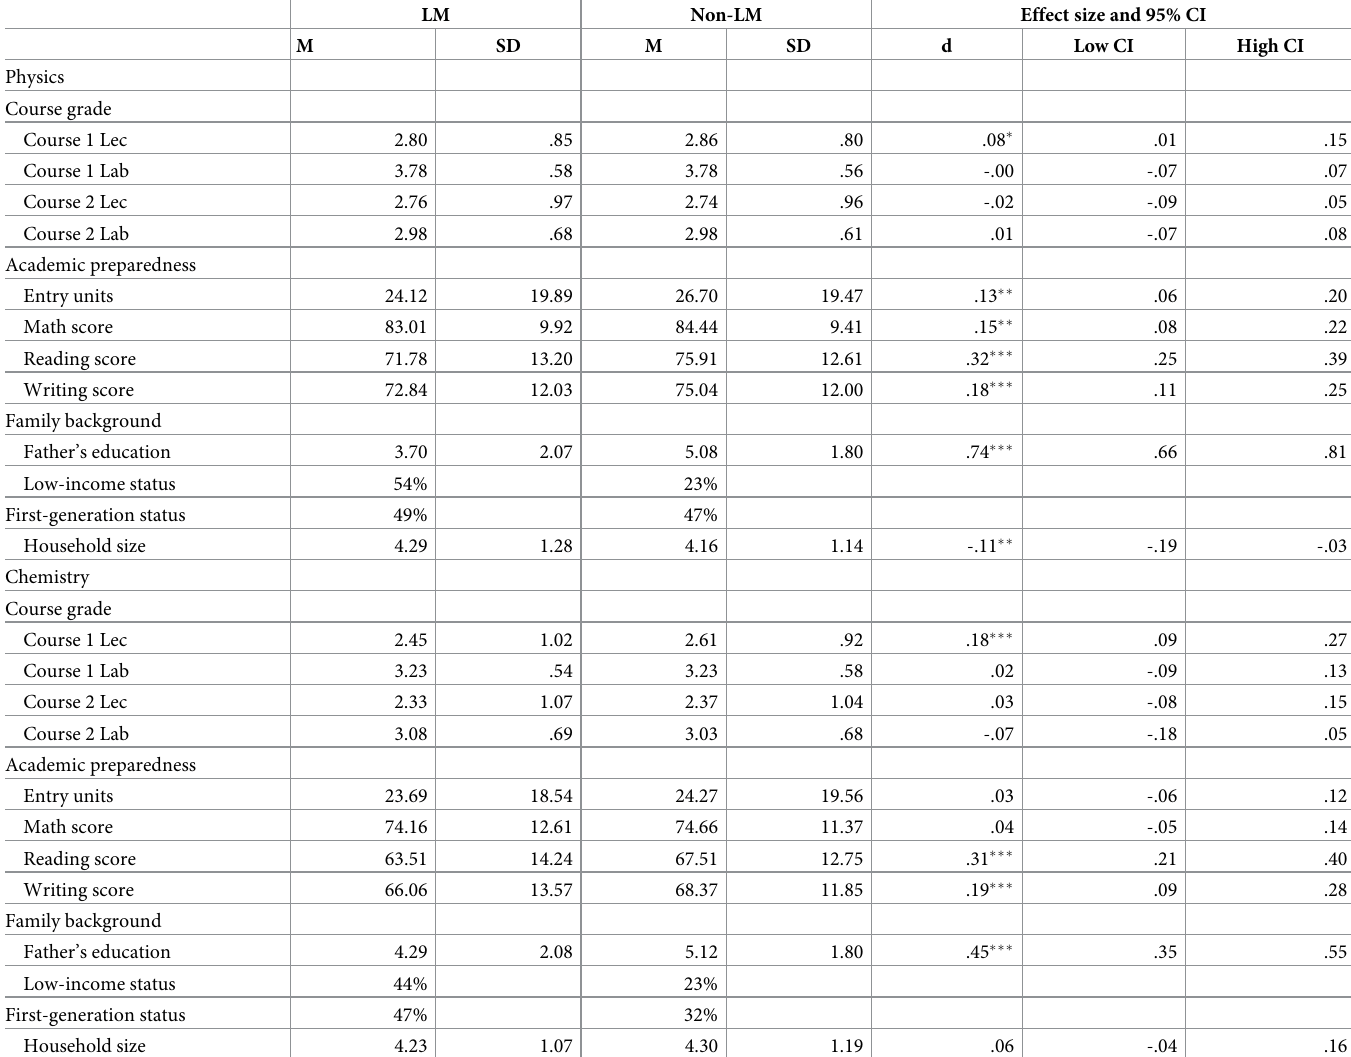
Table 2. Descriptive statistics and standardized mean differences by language